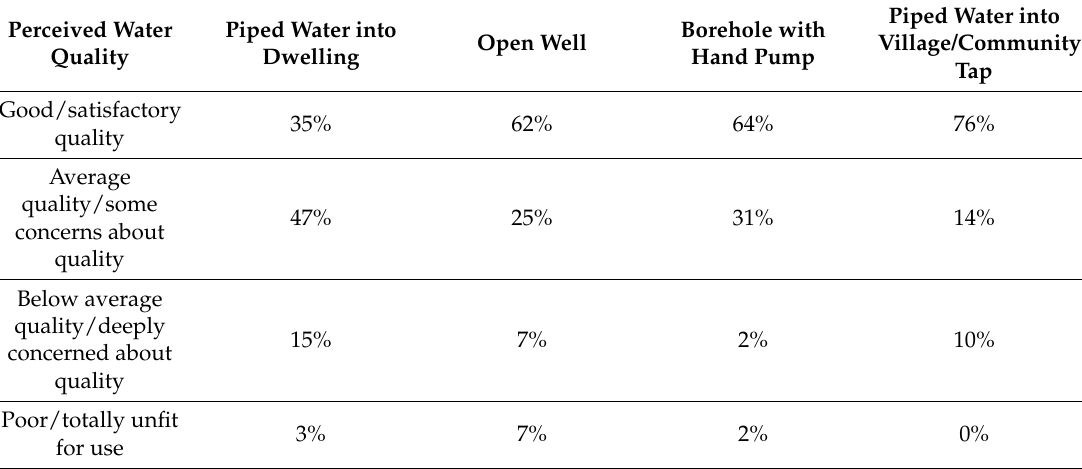
Table 2. Perceived water quality in monsoon season per supply